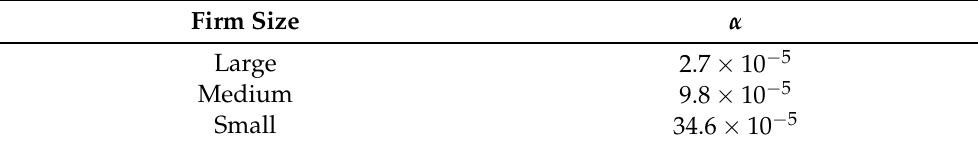
Table 1. Investment effectiveness α for different firm